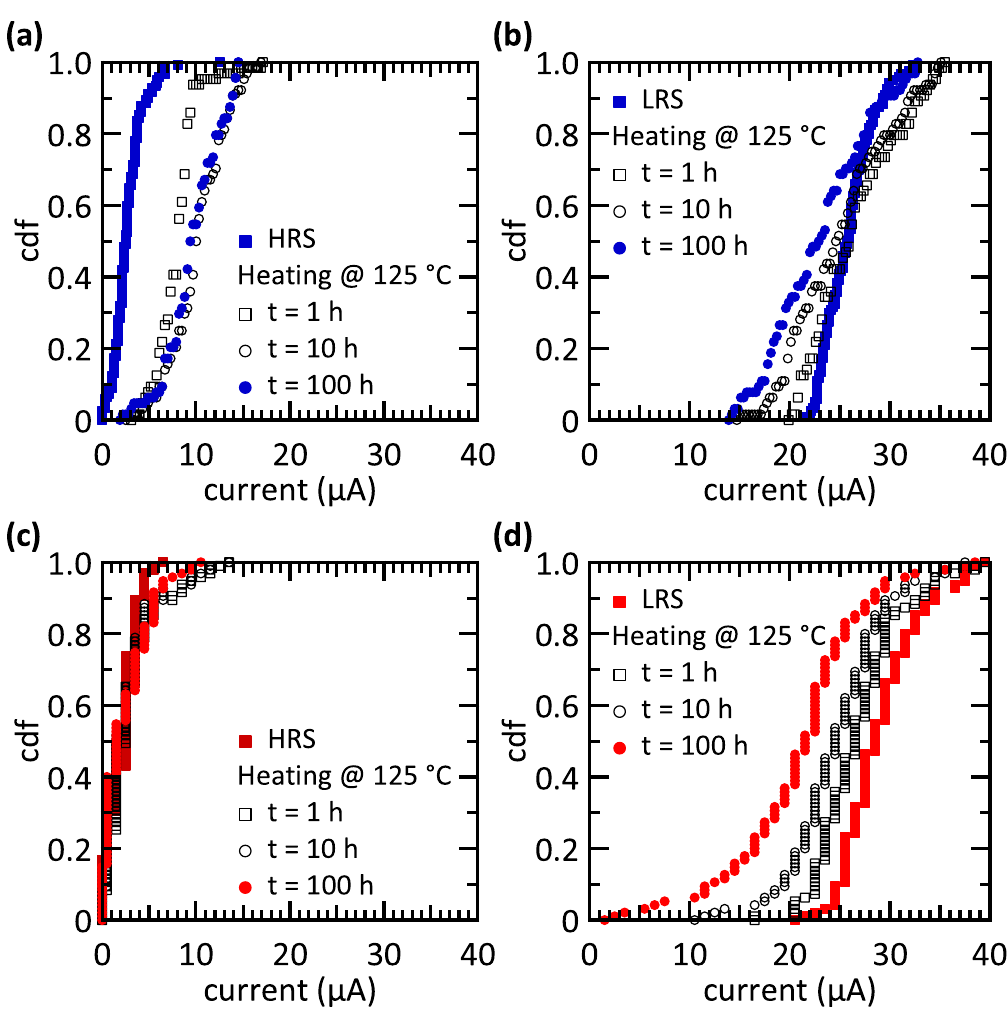
Figure 4. Retention of polycrystalline and amorphous devices. Plots ( a , c ) show the retention of the HRS for the polycrystalline and amorphous devices, respectively. In ( b , d ) the retention of the LRS is depicted for the polycrystalline and amorphous devices, respectively. The retention is measured for a temperature of 125 °C. Measurements are done with 128 devices for each technology with 10 µs read-out times. The current resolution for ( a , b ) is higher than for ( c , d ). The more quantised data for the amorphous devices do not show a more quantised retention